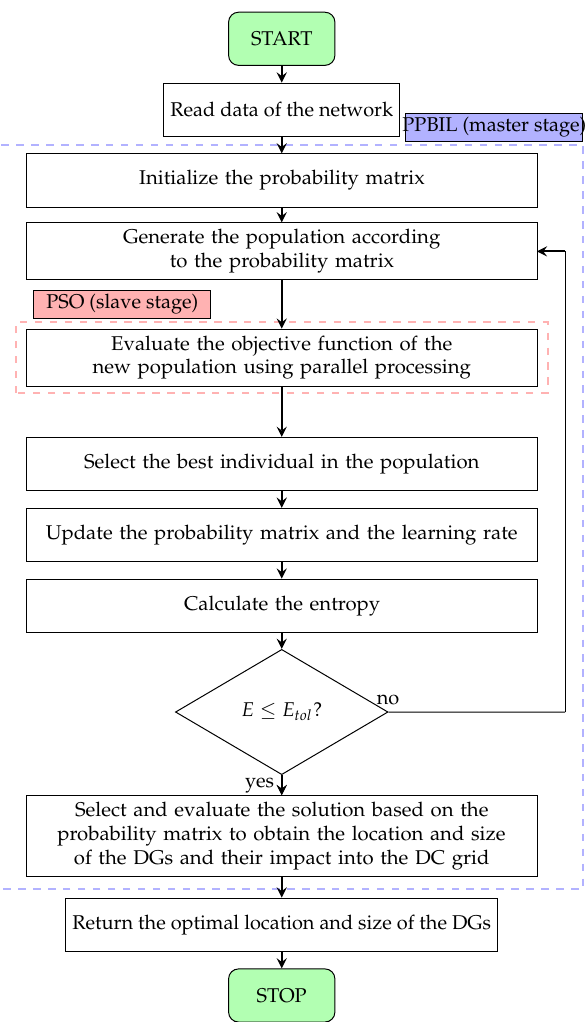
Figure 3. Proposed method based on the Population-Based Incremental Learning (PPBIL) and the Particle Swarm Optimization (PSO)